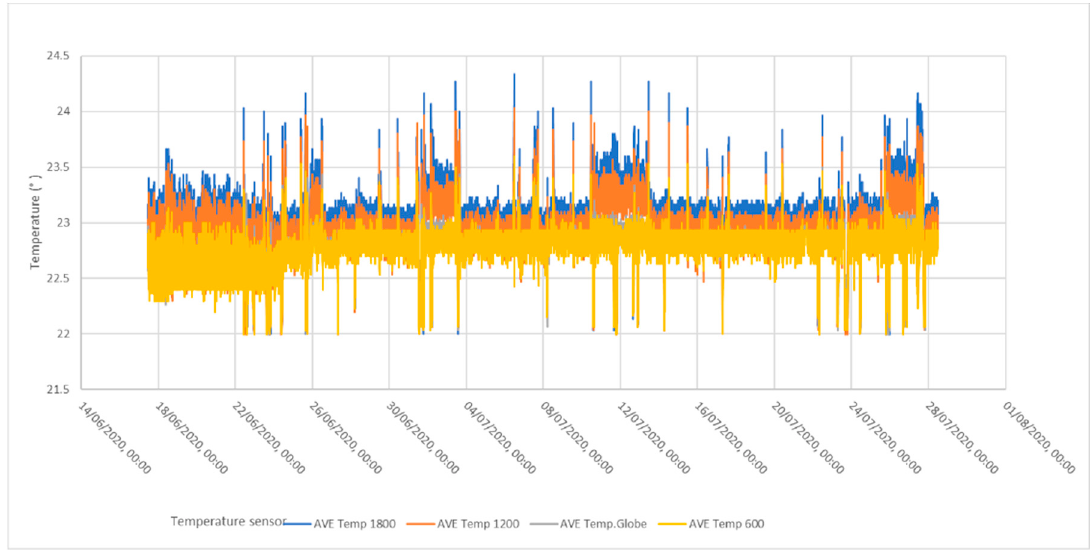
Figure 21. Temperature profile of the room aimed at 23 °C (+/ − 0.5 °C) for the testing period 2.